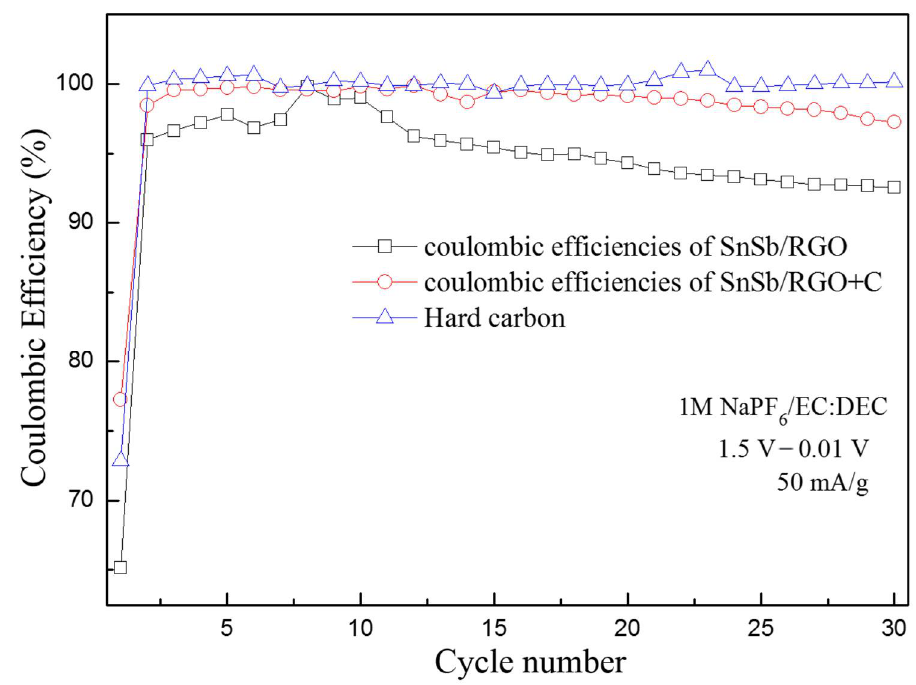
Figure 4. Coulombic efficiencies of SnSb/RGO, SnSb/RGO+C and hard carbon.